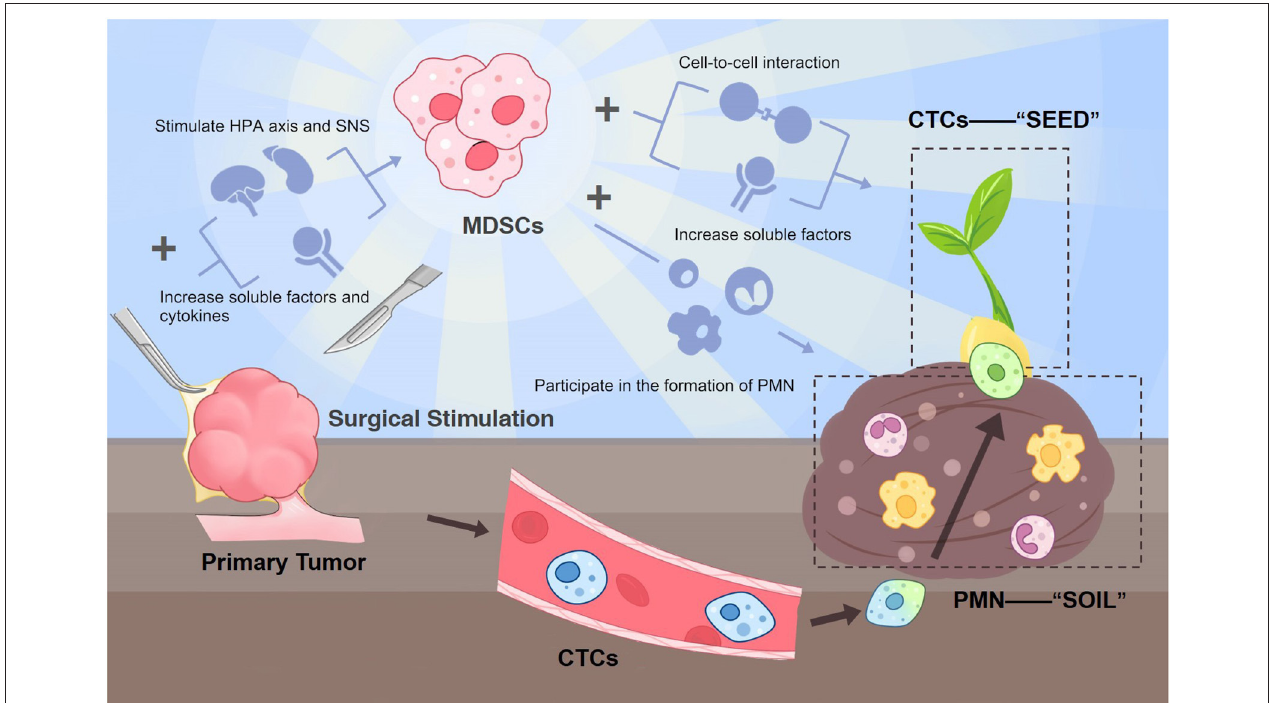
FIGURE 1 | A schematic diagram of this whole